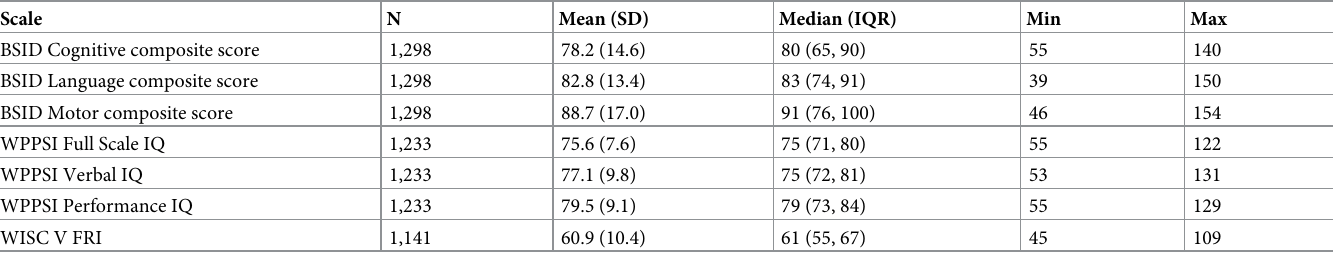
WPPSI Verbal IQ